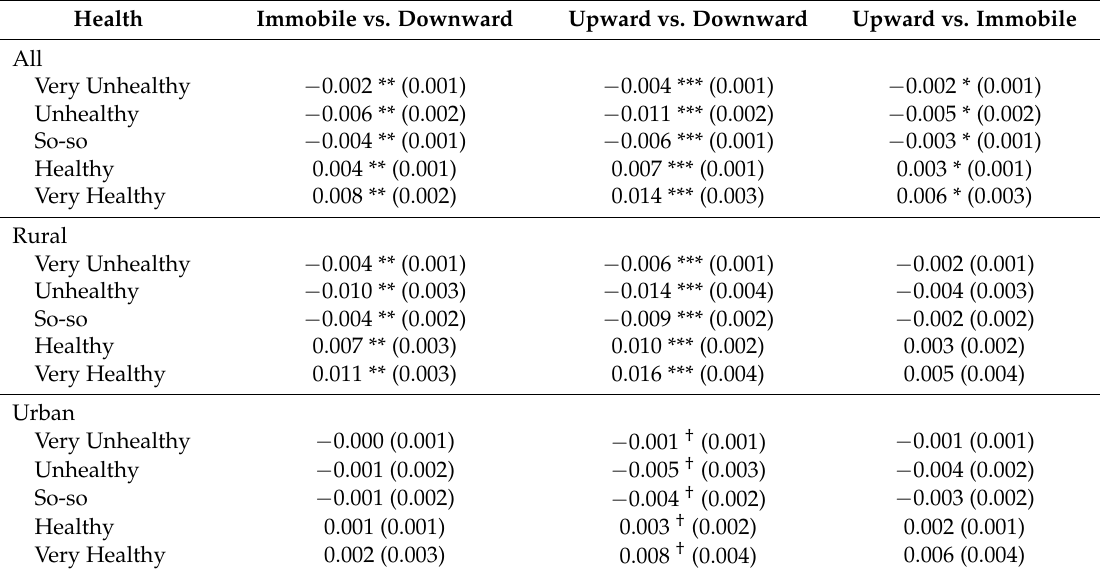
Table 5. Average Partial Effect of Self-Perceived Mobility.